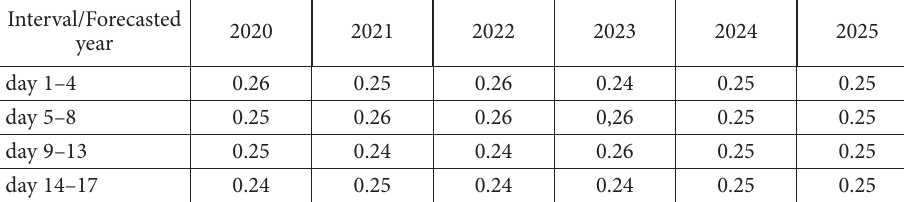
Table 10. Future number of enrolled students using Markov chains